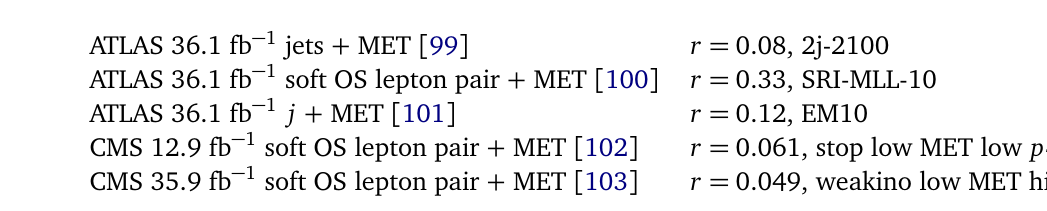
Table 3: Summary of constraints on benchmark point [ 1 ] from the most sensitive 13 TeV searches implemented in C HECK MATE at the LHC. The two last results where a similar analysis with less data is more sensitive can be explained by differences in the base selection criteria. All the signal regions shown here require at least / E (cid:166) 100 GeV. SRI-MLL-10 is inclusive in lepton flavor and select lepton pairs with T invariant mass m (cid:96)(cid:96) ∈ [ 1,20 ] GeV. EM2 simply requires / E the last region targets relatively compressed spectra and cuts on the leading lepton p T